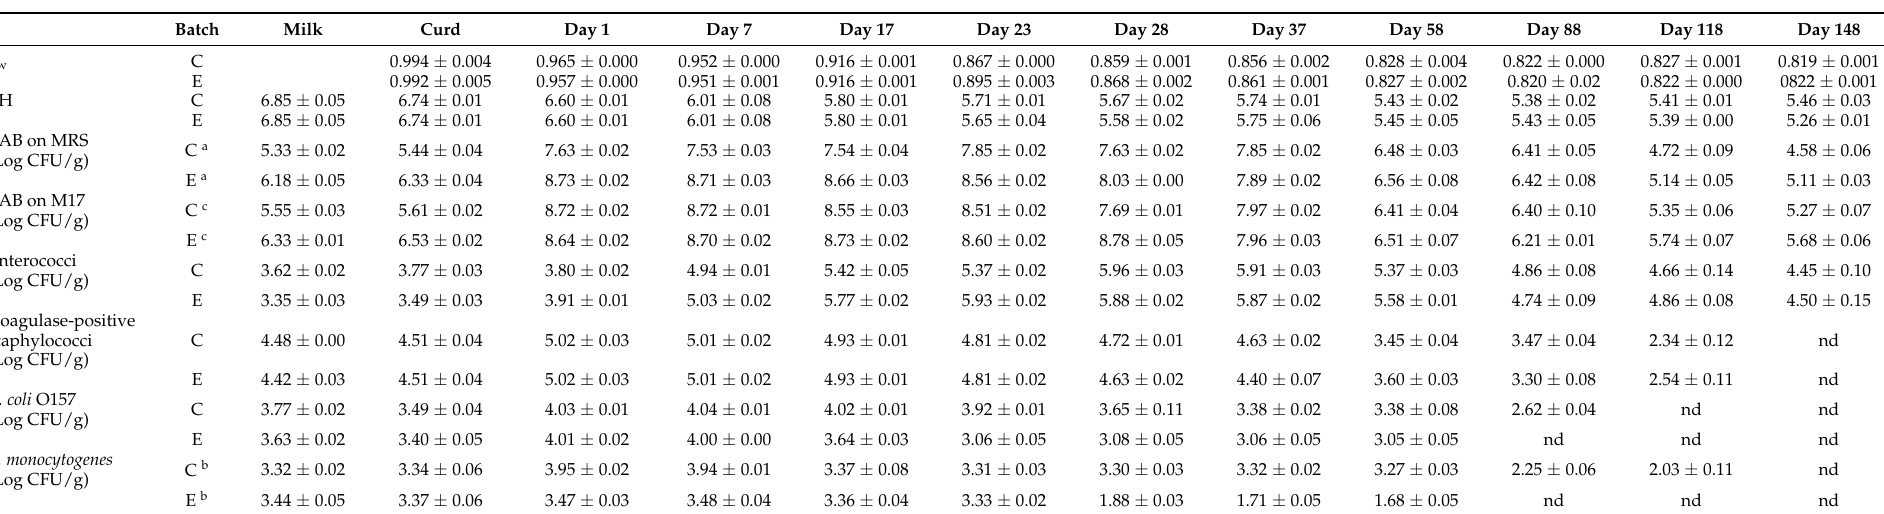
Table 3. Evolution of a w , pH and microbial groups in Pecorino di Farindola produced with (E) or without (C) the addition of the Lacticaseibacillus paracasei L11121